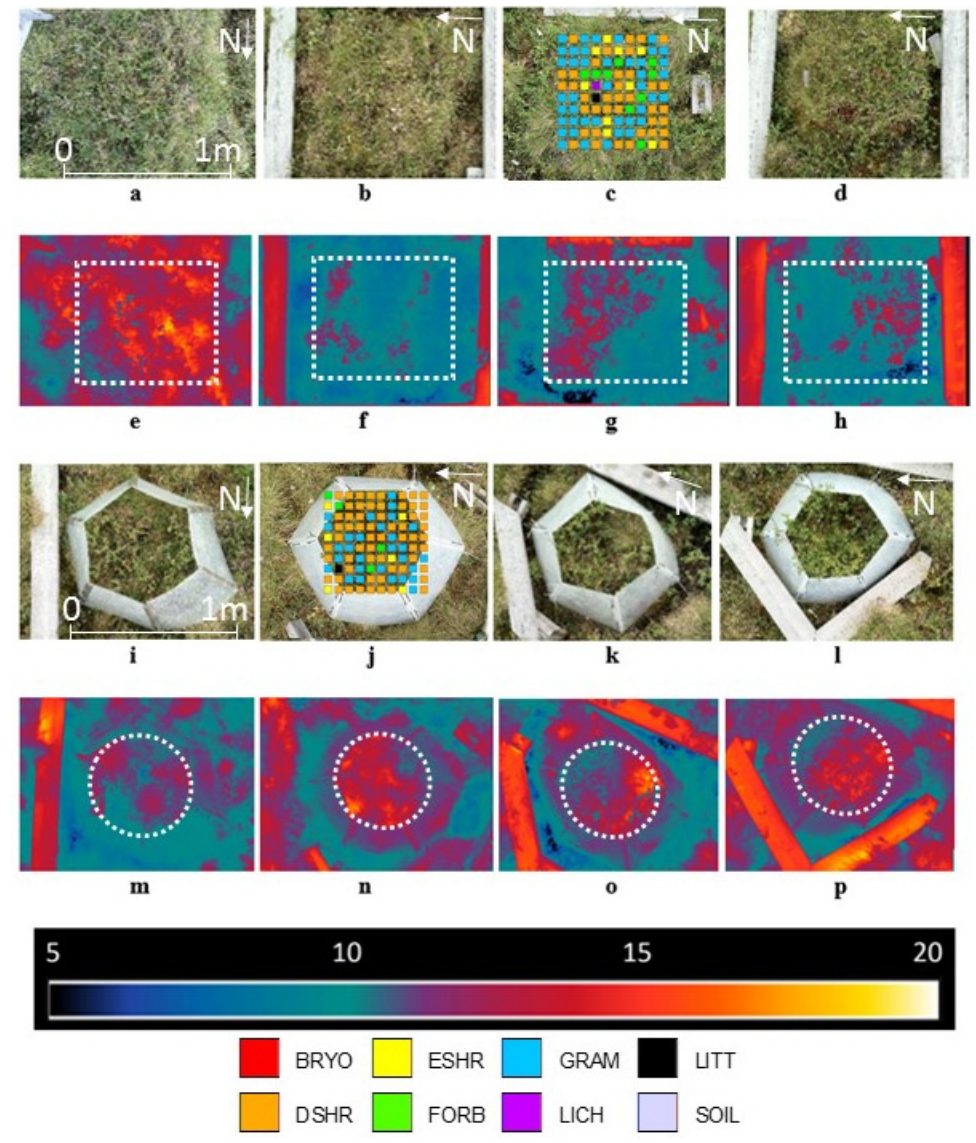
Figure 8. Images depicting four Toolik Lake moist site plots ( a – d ) and the coinciding thermal images below ( e – h ); and images of four additional plots ( i – l ) with coinciding thermal images below ( m – p ). Areas of image analysis are outlined with dotted white lines. All temperatures are in degrees Celsius.